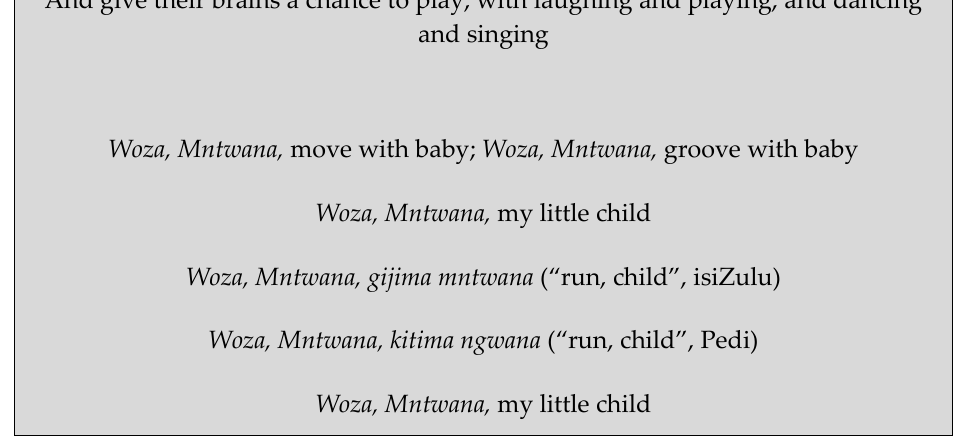
Figure 5. “ Woza, Mntwana” lyrics. Figure 5. “Woza, Mntwana”